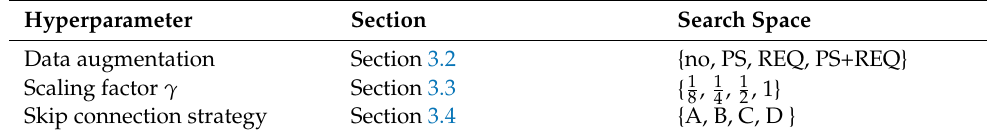
Table 3. Settings for the parameter optimization study described in Section 5.1.